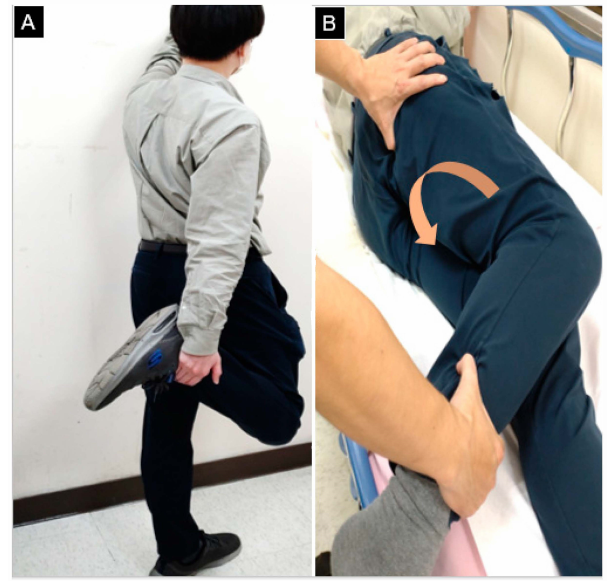
Figure 6. ( A ) Step 1: The volunteer’s hip is brought to extension, external rotation, and adduction to compress the ischiofemoral space in the upright position. ( B ) Step 2: The participant is in the lateral decubitus position with the knee being flexed and the hip being externally rotated (brown arrow). The examiner places the thumb over the ischium to check if the tenderness can be